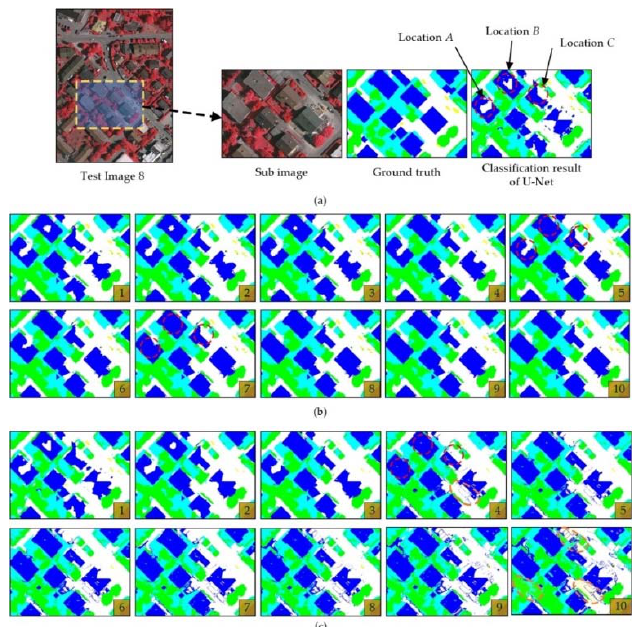
Figure 6. Detailed comparison of the results of the ELP and conditional random field (CRF) algorithms. ( a ) Ground truth and U-Net’s classification results of a subarea of test image 5; ( b ) results of ten iterations of ELP; ( c ) results of ten executions of CRF.